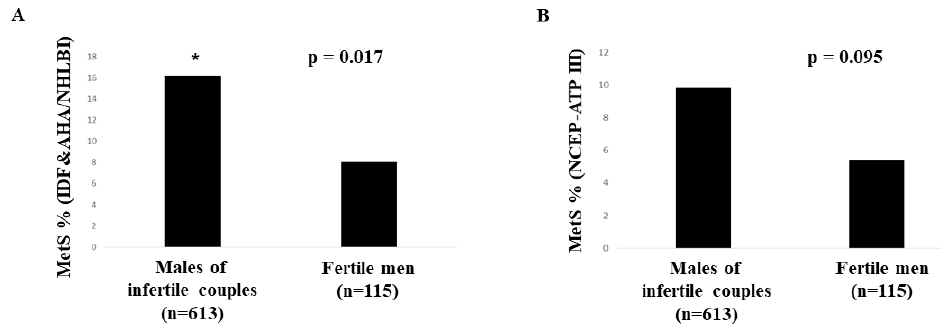
Figure 1. Comparison of metabolic syndrome (MetS) prevalence in fertile and infertile men derived from the database of the Andrology Unit of the University of Florence, according to IDF&AHA/NHLBI ( A ) and NCEP-ATPIII ( B ) criteria. * p <